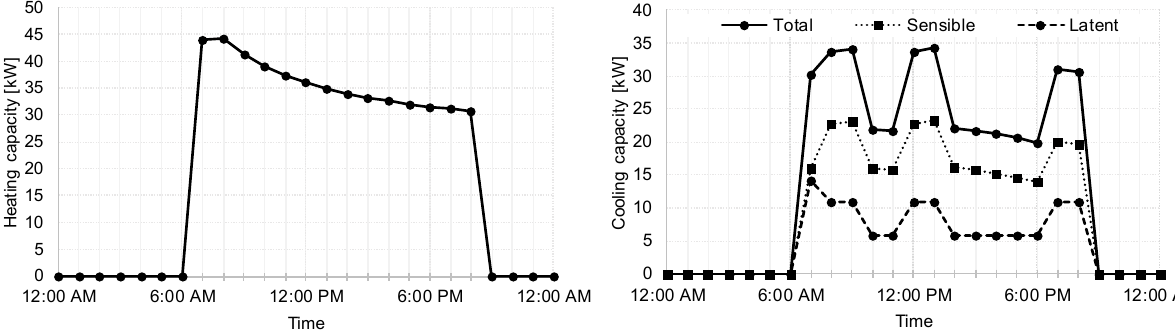
Figure 4. Daily variation of design load for heating ( left ) and cooling ( right ). The energy generated by a centralized hydronic system for heating and cooling is distributed to fan coils in the restaurant. All systems have the same water temperature, which is 50/45 °C for heating and 7/12 °C for cooling. Central heating of DHW is provided in the building, and therefore, it is included in all the systems. Cold water is heated from a temperature of 12 to 45 °C. DHW consumption was monitored in the period from Janu- ary 2017 to December 2018. Daily consumption varied from 1800 to 2600 L/day. According to [31], DHW consumption equaled the range of 12 to 30 L/person/day at the temperature of 45 °C; thus, the measured values are in accordance with those from the literature. The monitored data are used to the create a consumption profile for a standard day in a year, as shown in Figure 5.